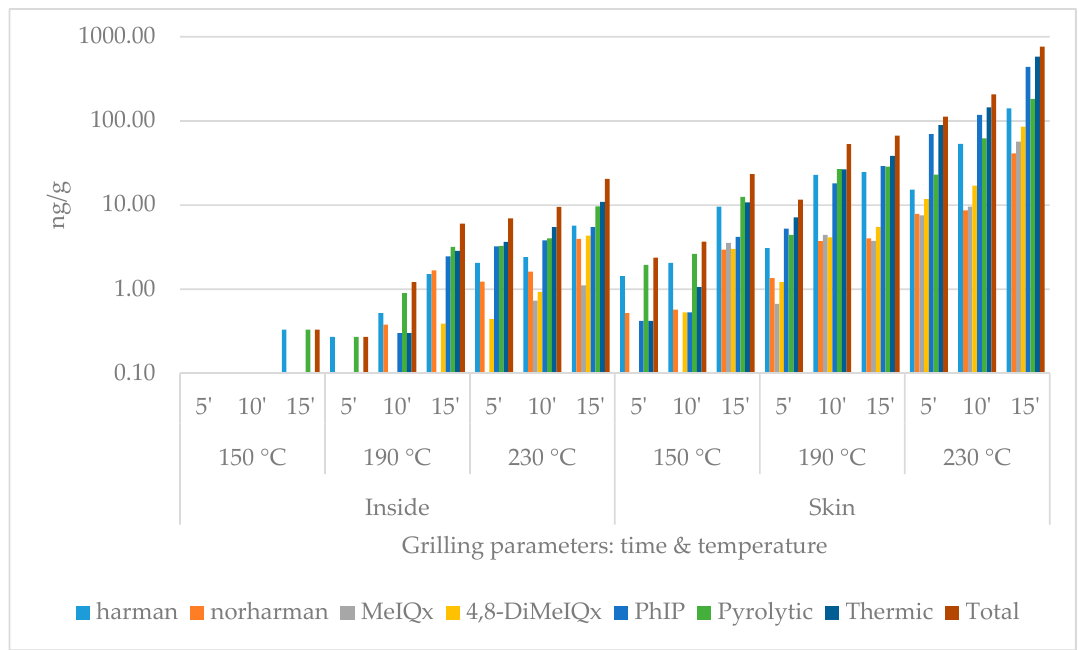
(logarithmic scale).